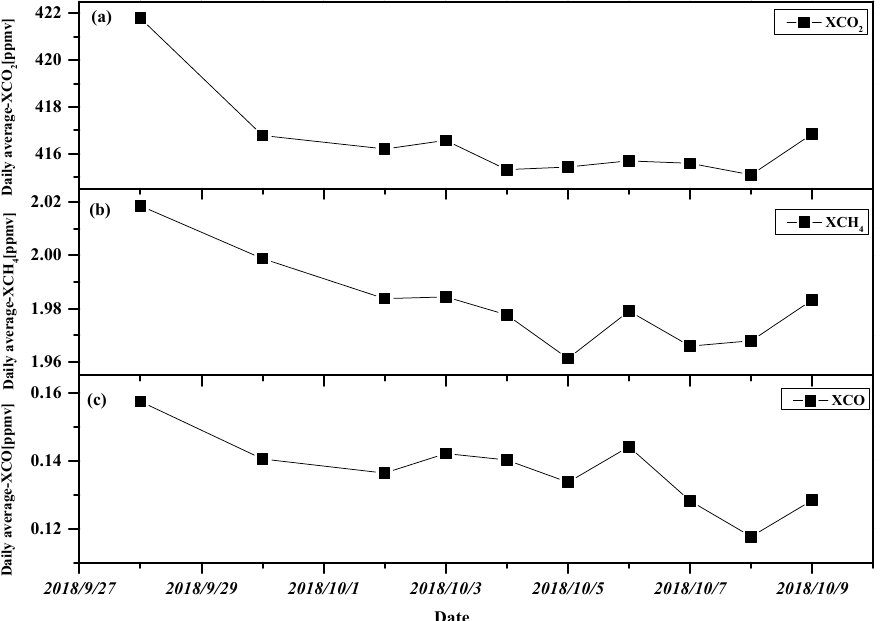
Figure 7. Time series of the daily averages of XCO 2 ( a ), XCH 4 ( b ) and XCO ( c ) observed with the EM27/SUN spectrometer.